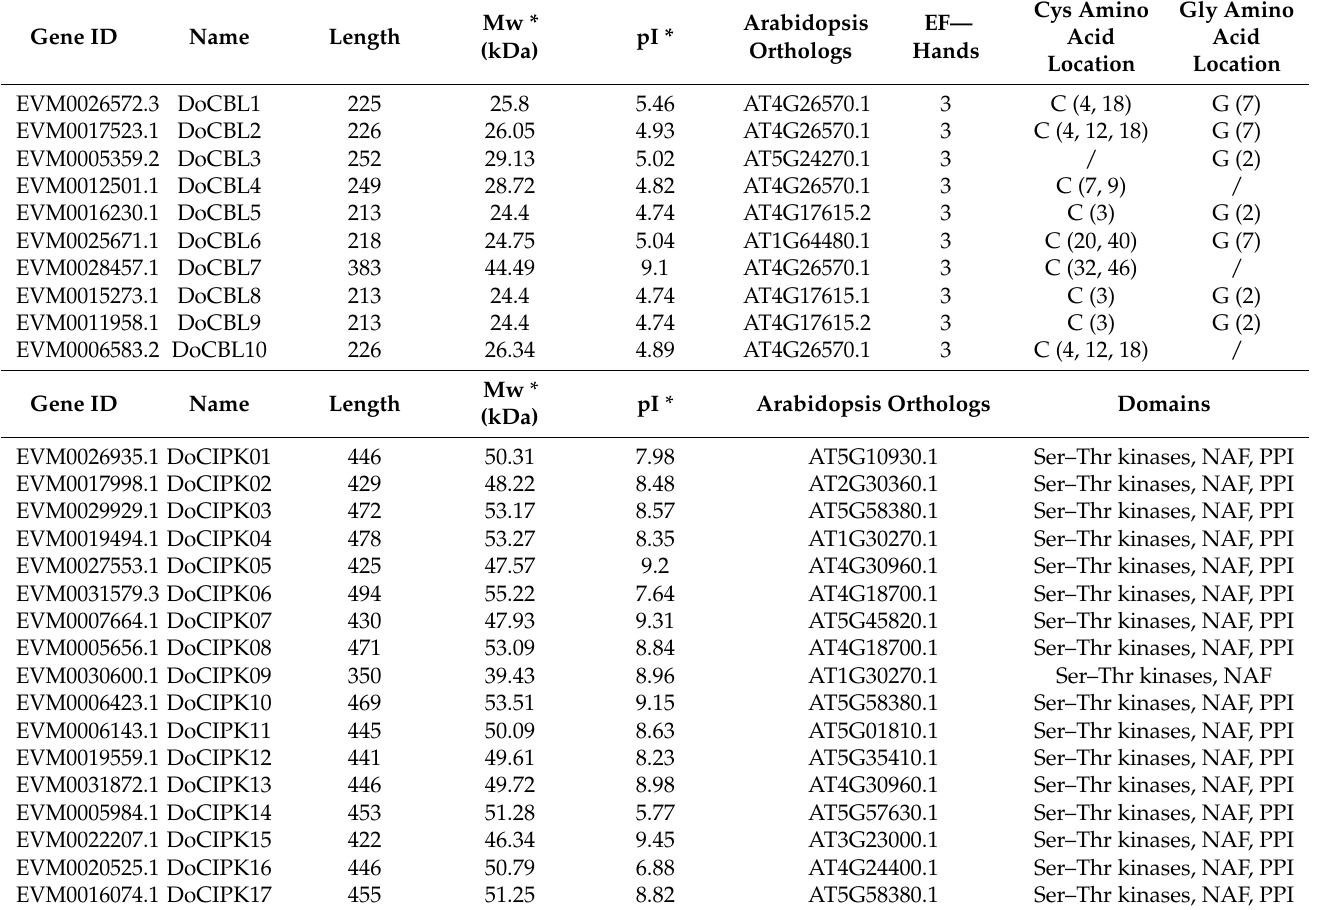
Table 1. Characteristics of CBL–CIPK genes identified from oil